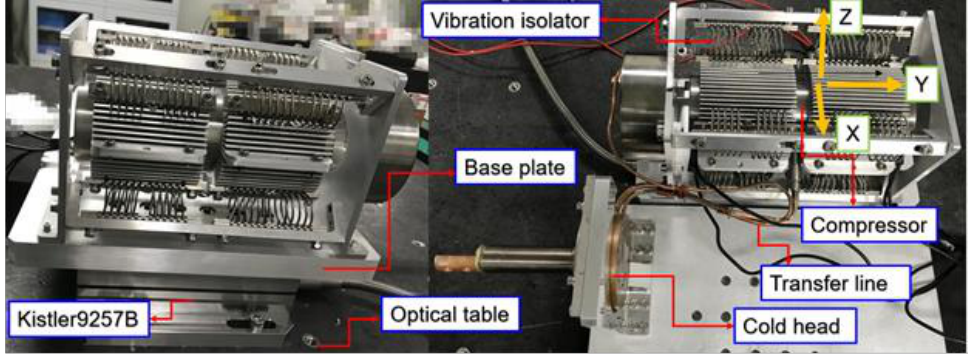
Figure 4. Test configuration of the compressor isolation performance on the Kistler9257B.